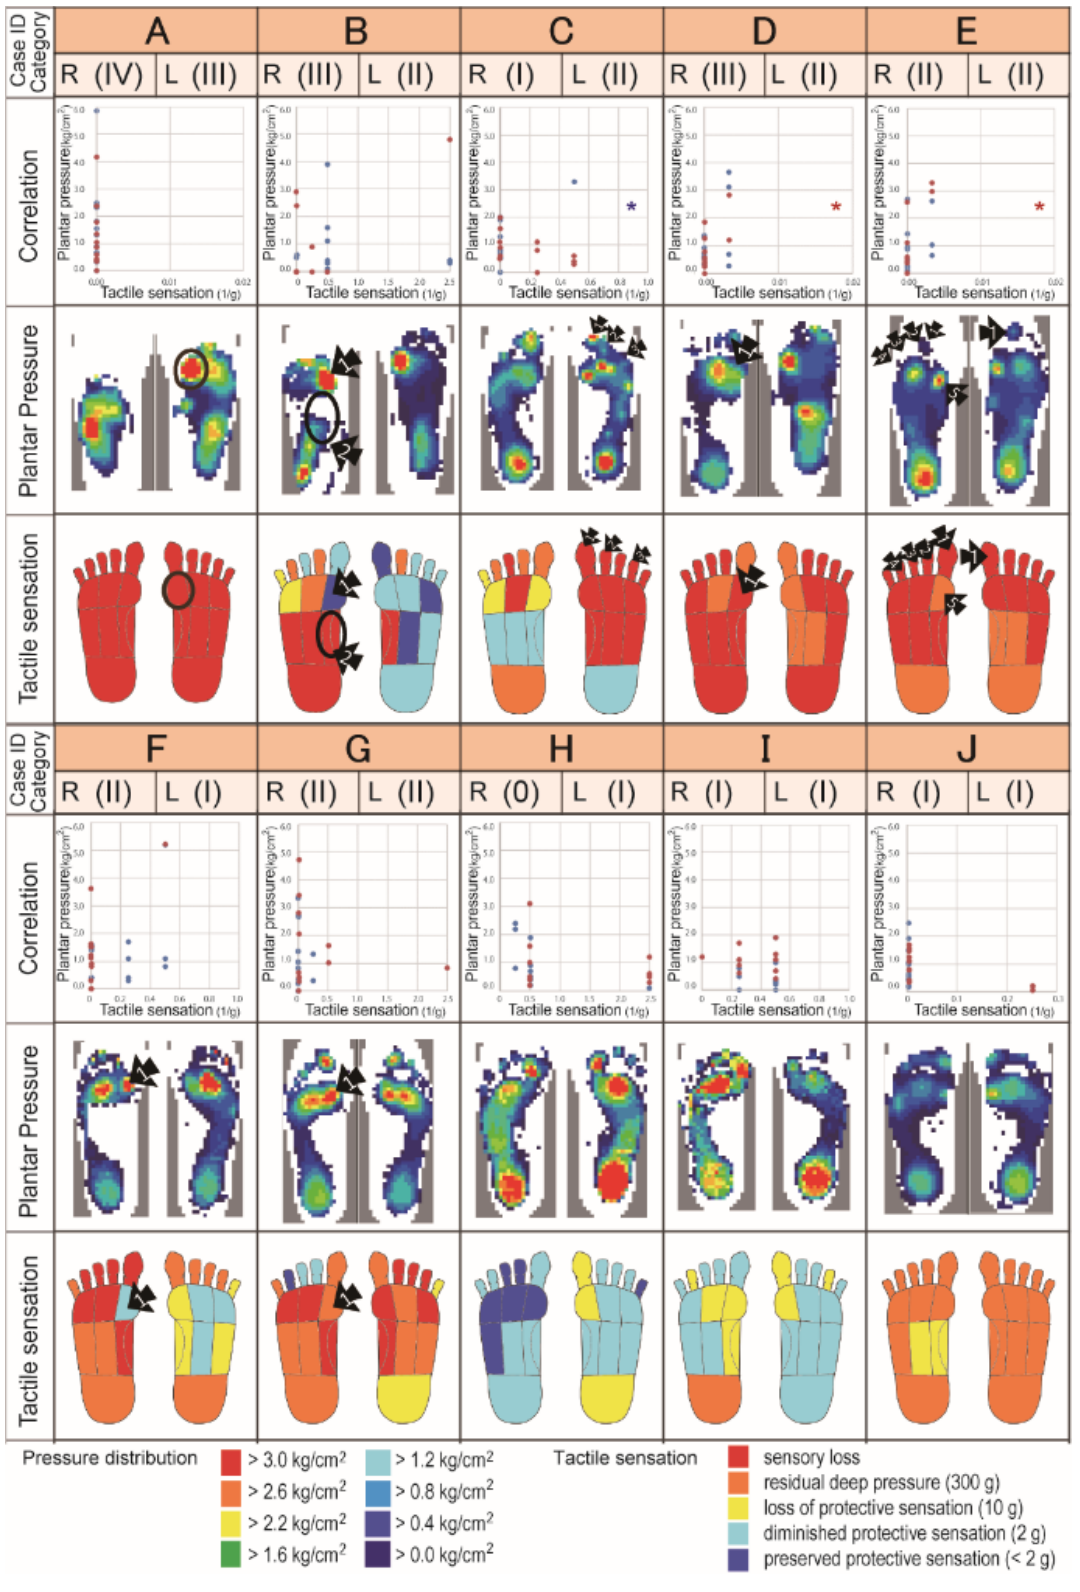
Figure 2. Clinical feature of each foot. The present or past ulceration, tactile sensory threshold, dynamic pressure, and correlation between sensation and dynamic pressure are summarized.